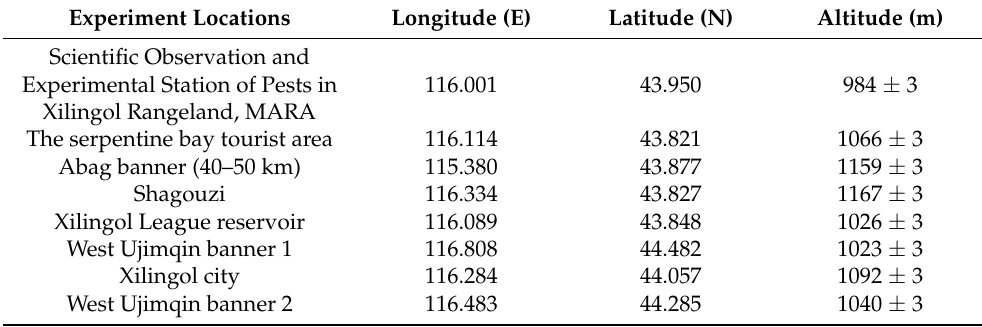
Table 1. Location of the study areas in the Xilingol League, Inner Mongolia, China.